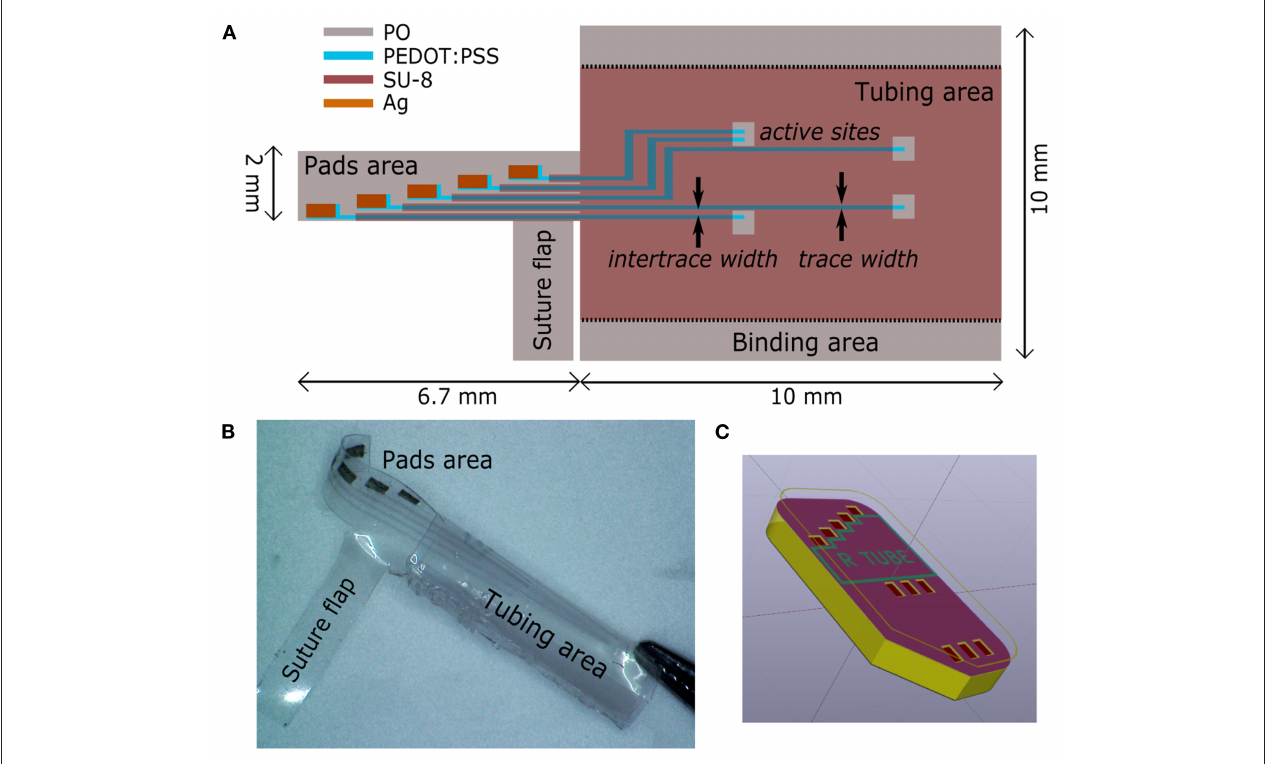
FIGURE 2 | Regenerative nerve Cuff Electrodes (RnCEs). (A) Planar view of the final device, with the design of the tube lumen and geometrical references before the rolling up. (B) Picture of the final RnCE. (C) Rendering of the device with an inset of the custom